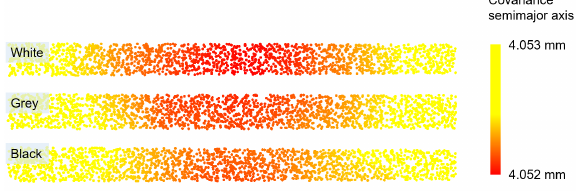
Figure 13. Semimajor axis of the error ellipsoid estimated for the scan at 60m range and 0 ◦ incidence angle. The different models for the different materials show different patterns, even though the absolute values are not affected much in this